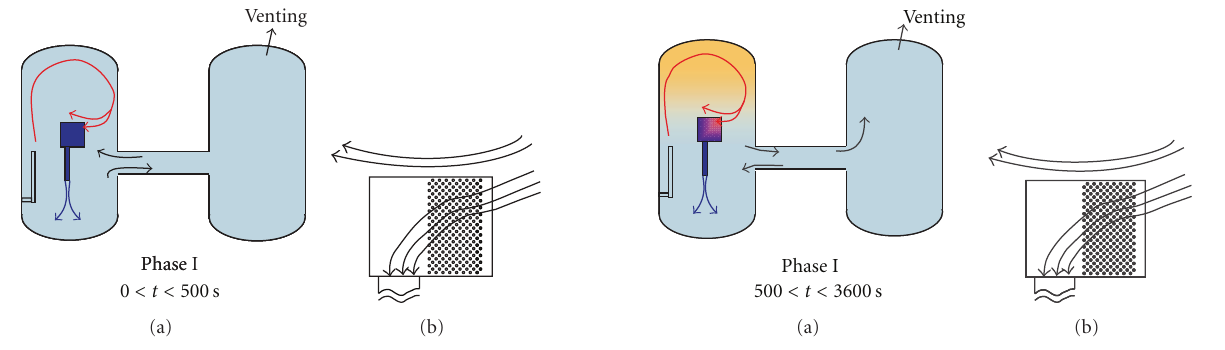
Figure 12: Suggested flow pattern for 0 < t < 500 s. Figure 13: Suggested flow pattern for 500 < t < 3600